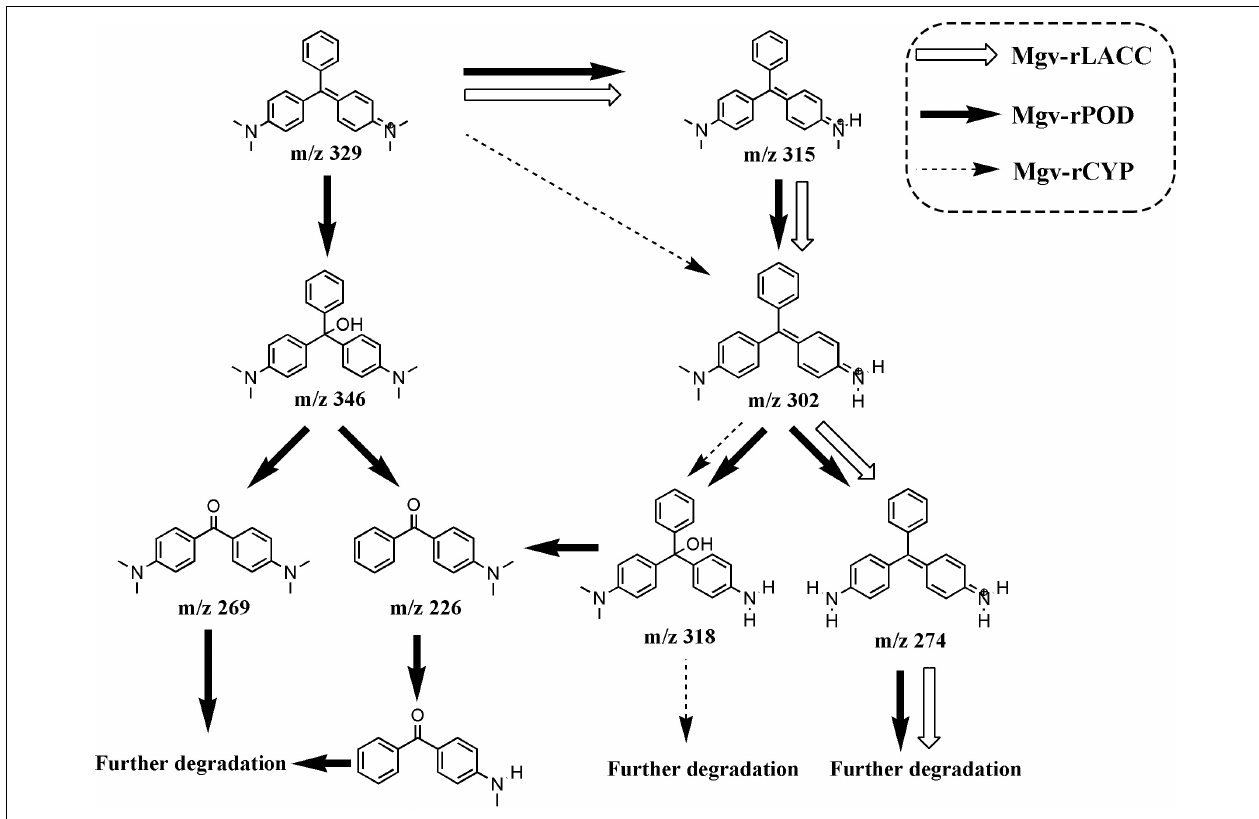
FIGURE 7 | The putative MG degradation pathway deduced from the products of Mgv-rPOD, Mgv-rLACC, and Mgv-rCYP. The intermediates connected by the black, white and dashed arrows indicated the MG-degrading pathway of Mgv-rPOD, Mgv-rLACC, and Mgv-rCYP,